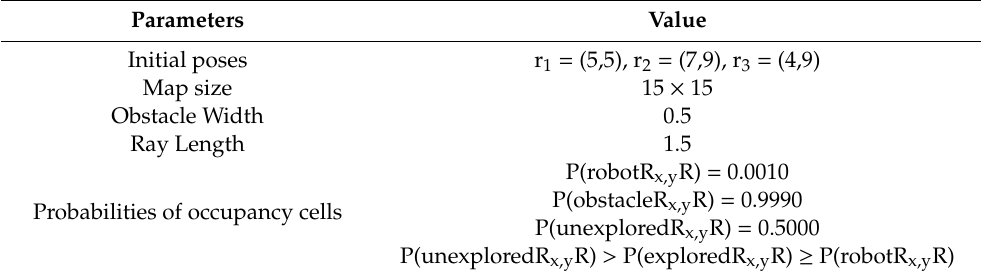
Table 1. Experimental parameters.